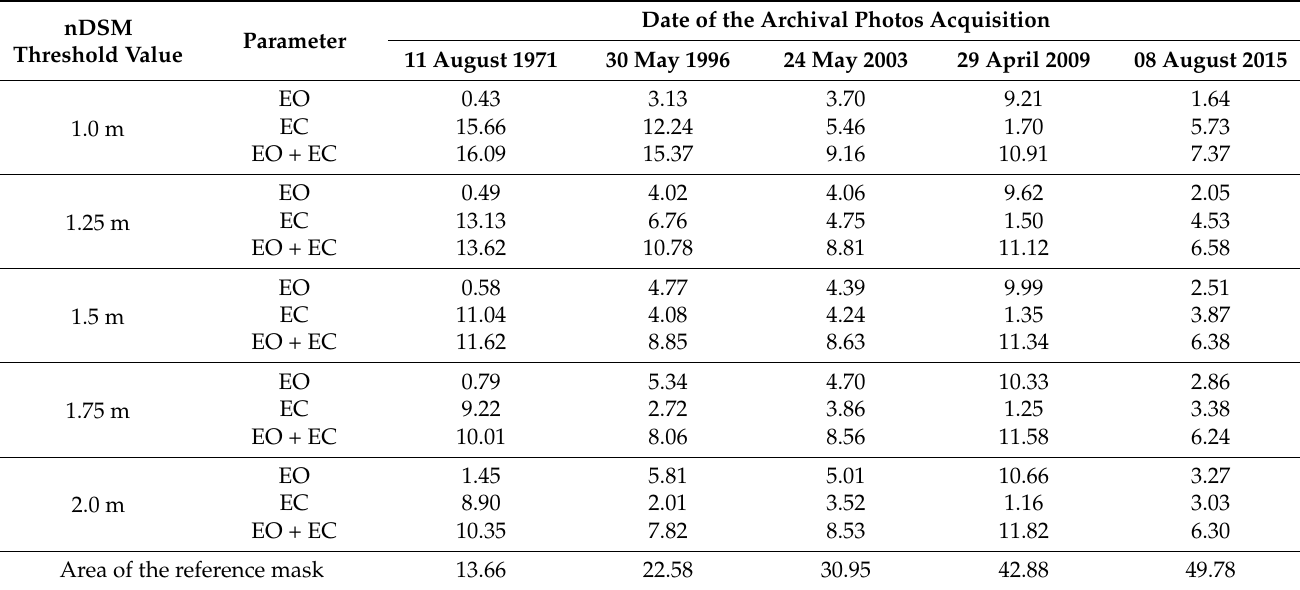
Table A2. Area of omission (EO) and area of commission (EC) [in hectares] report of shrubs and trees extent determination (nDSM obtained using a dense image matching algorithm on archival aerial photos), OM1 study area.